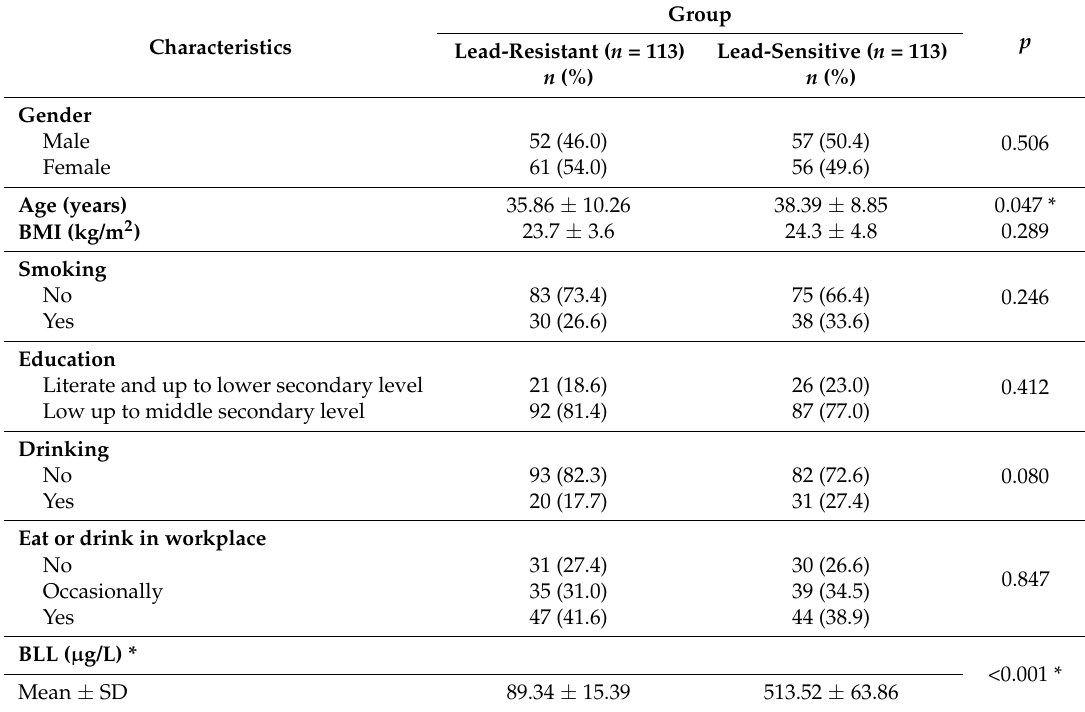
Table 1. The characteristics of the 10% most lead-sensitive and 10% most lead-resistant